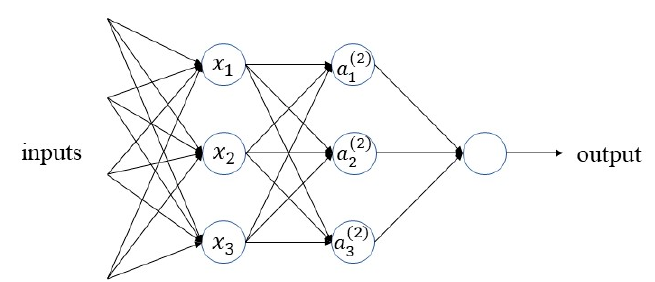
Figure 1. Three-layer neural network structure.